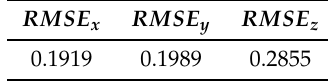
Figure 9. Second simulation: x and y axis were trained beforehand. Now z axis is added and initialized with random weights. Dashed line represents the reference and solid lines describe the output of the system. Table 1. Root Mean Squared Error (RMSE) for each axis from simulation from Figure